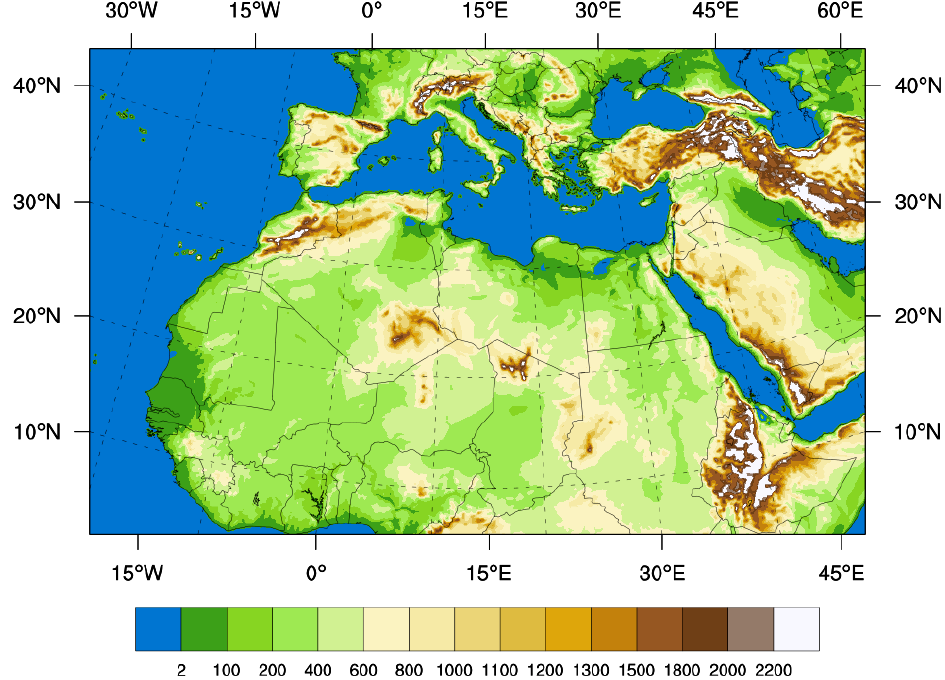
Figure 1. WRF-Chem computational domain used in the study. The topography (in meters) is also depicted. Table 1. Physical parameterizations used in this work .